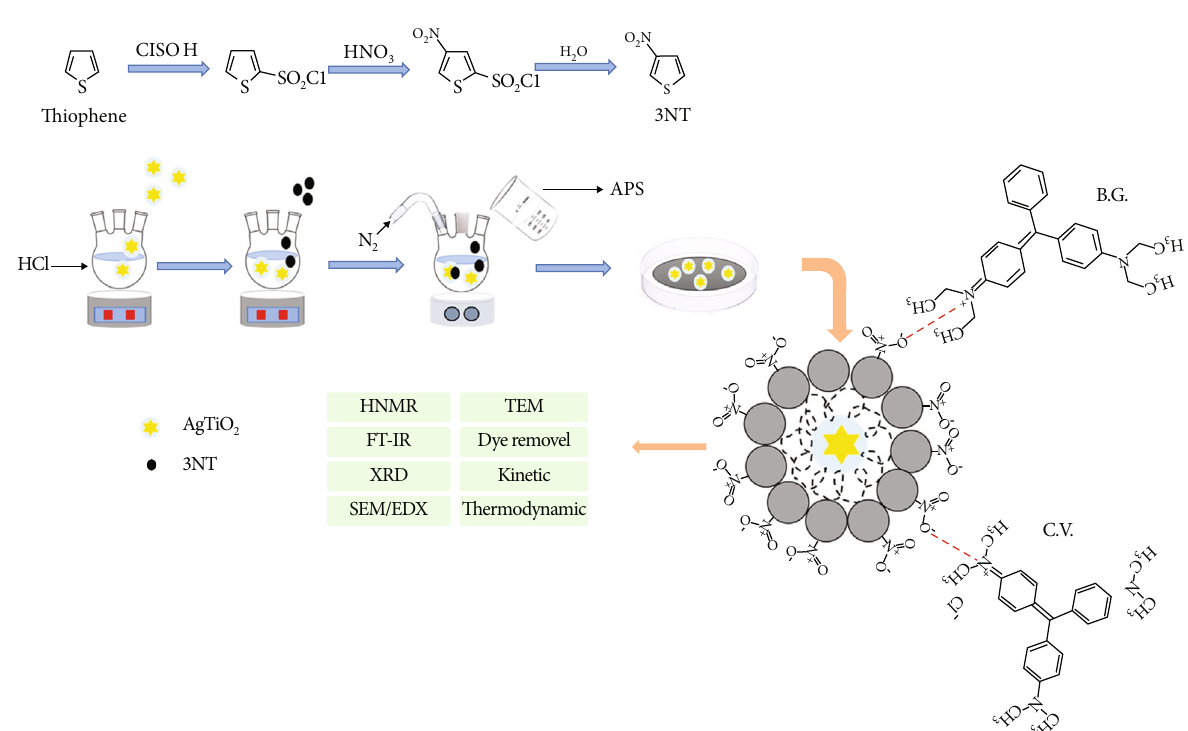
NCs and adsorption of B.G. and C.V. dyes on the binary P3NT/ 2 NCs. 2